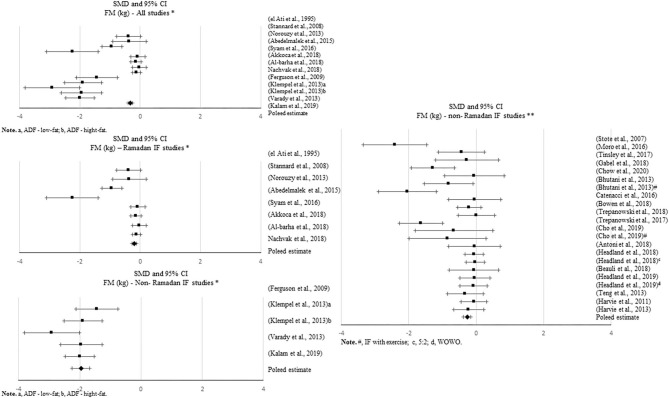
Forest plot of the effects from a random-effects meta-analysis shown as standardized mean difference with 95% confidence intervals on body mass index (BMI) for all studies and only non-Ramadan IF studies. For each study, the square represents the standardized mean difference between pre-post data intervention and control groups, with the horizontal line intersecting it as the lower and upper limits of the 95% confidence interval. Forest plot of the effects from a random-effects meta-analysis shown as standardized mean difference with 95% confidence intervals on body mass index (BMI) for only Ramadan IF studies. For each study, the square represents the standardized mean difference between pre- and post-intervention time points. The rhombi represents the pooled estimated standardized mean difference. *Pre-post tests, IF intervention; **Pre-post tests, IF intervention vs. control.